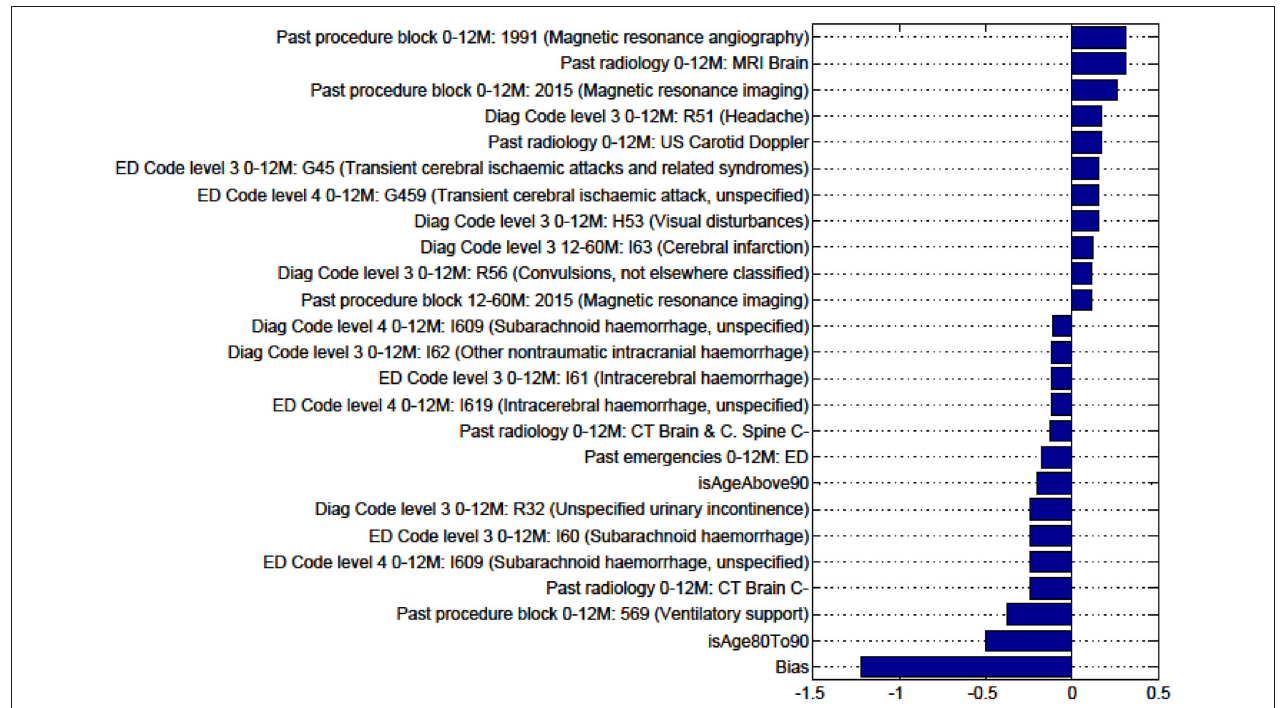
FIGURE A1 | Factors for prediction of Discharge Home vs all Other discharge destinations for the sub-cohort of Intracerebral haemorrhage stroke